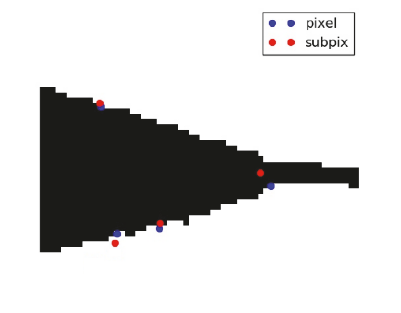
Figure 4: Subpixel positions of corners at the matched precrack